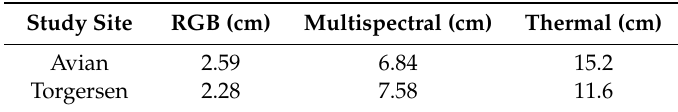
Table 1. Ground Sampling Distance (GSD) for optical Red Green Blue (RGB), thermal and multispectral imagery of each island used in